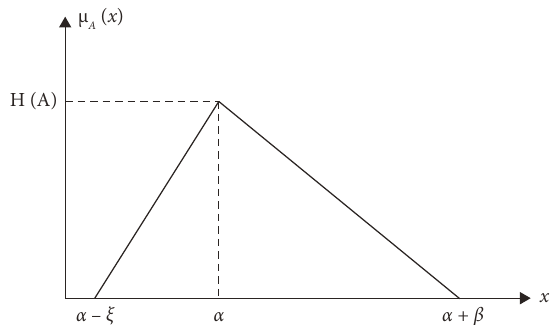
Figure 1: Representation of subnormal/normal of a triangular type-1 fuzzy